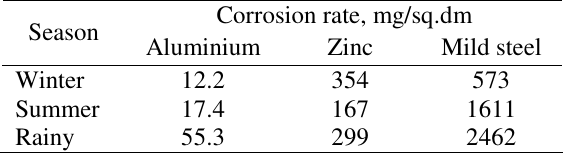
Table 2 . Average seasonal corrosion rate (in mg/sq.dm).